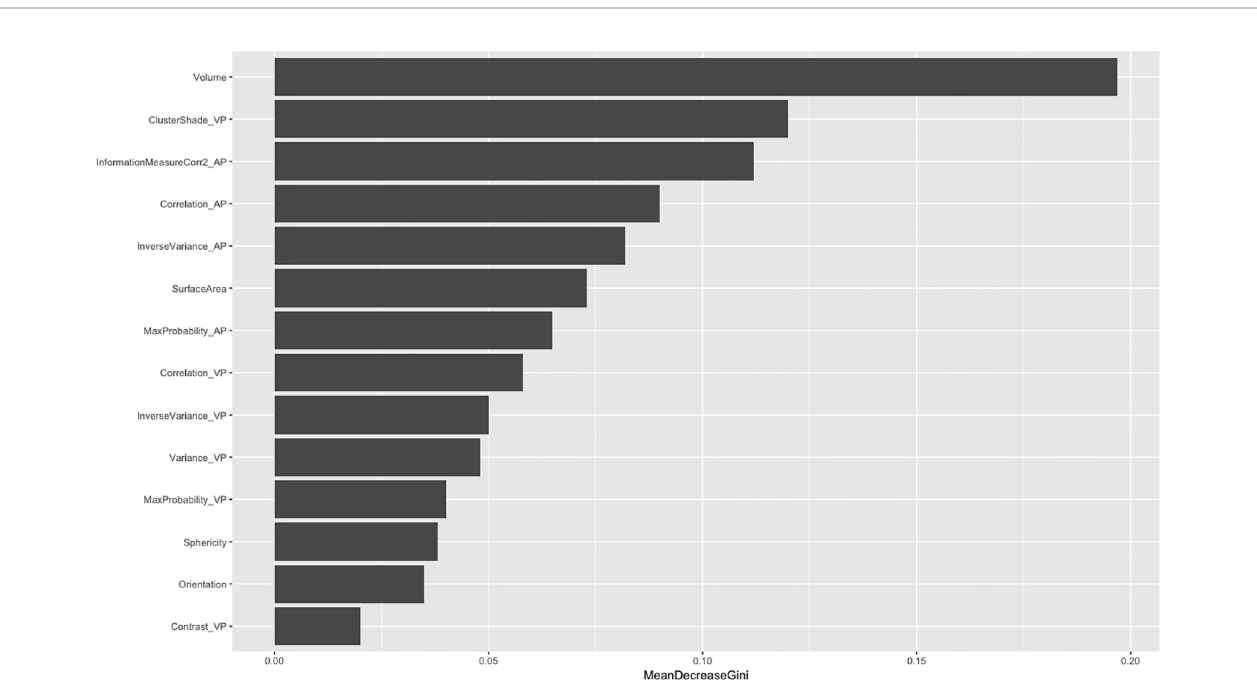
FIGURE 2 | The importance of radiomics features. AP, arterial phase; VP, venous phase.